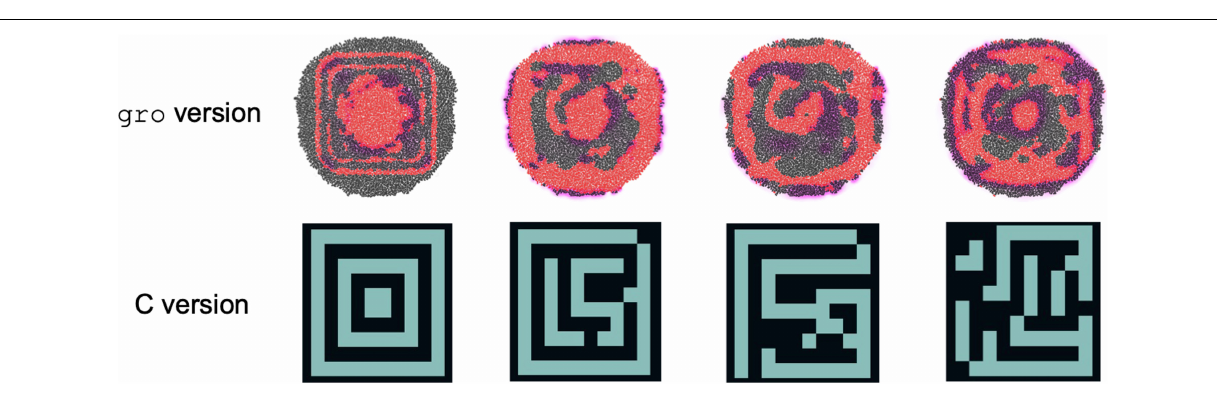
FIGURE 7 | Comparison of spatial patterns achieved by Conway’s Game of Life implementations in gro and in C. In the gro implementation, red cells represent live ones, and uncolored cells represent dead ones. The magenta regions are locations at which there is a high concentration of AHL. In the C implementation, cyan cells are live ones and black cells are dead